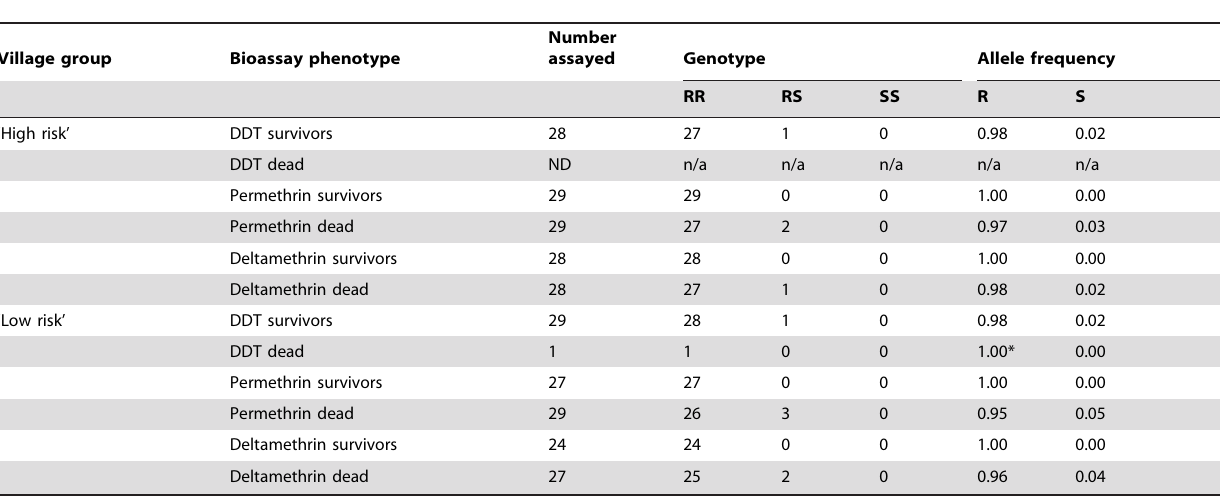
Table 2. kdr genotype frequencies in field populations of Anopheles arabiensis from southwestern Ethiopia according to their survival in the bioassay